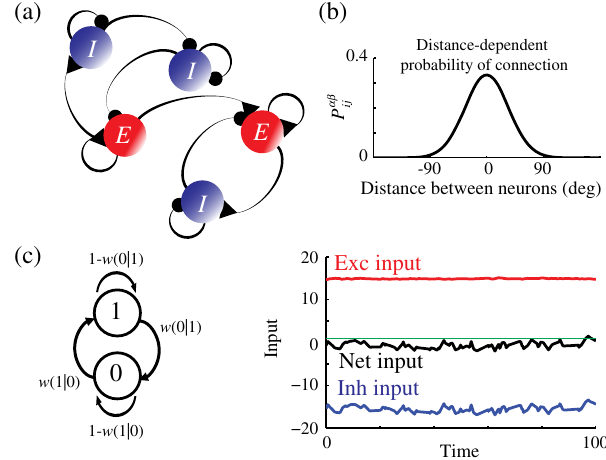
FIG. 1. Network architectures and dynamics. (a) Networks consist of D populations of neurons, excitatory ( E , red), and inhibitory ( I , blue) recurrently coupled and receiving external drives. Triangles: Excitatory connections. Circles: Inhibitory connections. (b) The neurons in each population are located on a one-dimensional network with periodic boundary condi- tions. The probability that neuron ð j; β Þ is connected to neuron ð i; α Þ depends on their distance. (c) Left: Neurons are binary units with zero-temperature Glauber dynamics. Right: The network operates in the balanced regime. Red: Excitatory input into a neuron. Blue: Inhibitory input into the same neuron. Black: The net input is on the order of the threshold (green, T ¼ 1 ). Time is given in units of τ ¼ 1